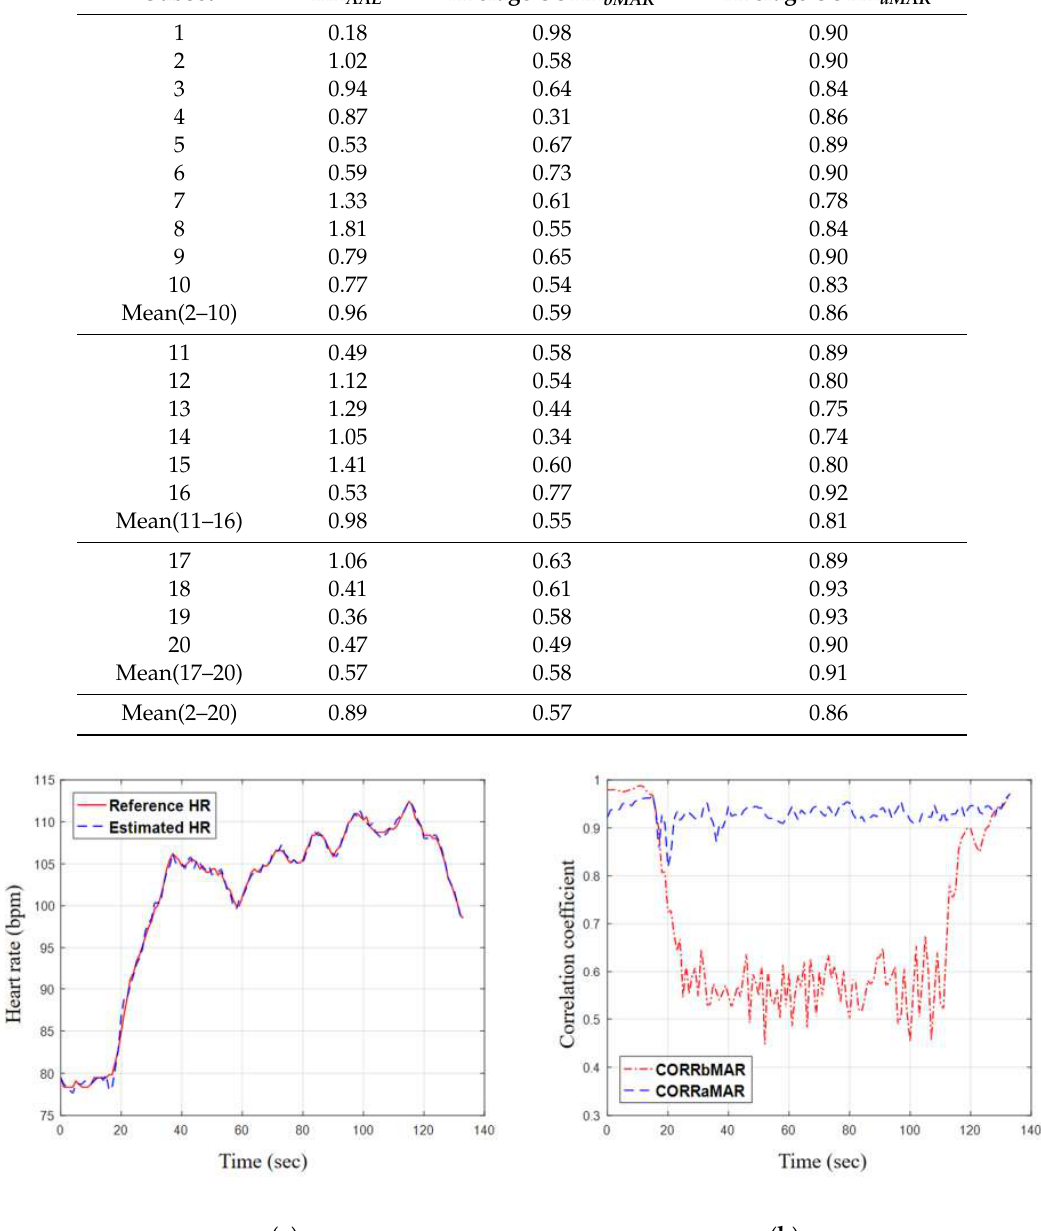
( b ) Figure 10. Taking subset 8 (the worst case) for example to further analysis: ( a ) the contrast curves of HR estimation results and the reference HR values; ( b ) correlation curves against time. 4. Discussions and Conclusions PPG sensors have been widely used in wearable health tracking, from the early HR monitoring to the present BP and SpO 2 monitoring. However, the accuracy of PPG sensors during exercise is unsatisfactory due to the motion artifact. At present, many studies have proposed methods to improve the accuracy of HR monitoring, which ignore the morphological recovery of the PPG signal. It limits